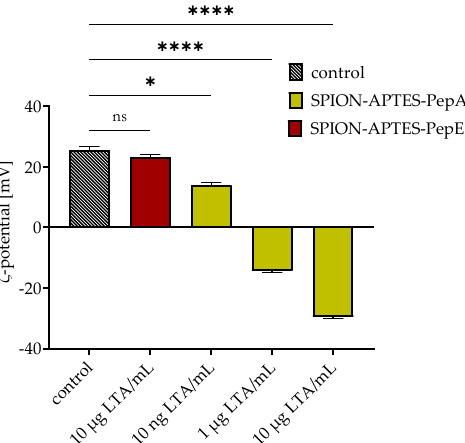
Figure 8. Changes in ζ -potential after separation of different amounts of LTA (10, 1000, and 10000 ng LTA/mL) using 300 µg Fe/mL of SPION-APTES-PepA and SPION-APTES-PepE. SPION-APTES- PepA without added LTA during separation served as control. The results shown represent the mean values with standard deviations of three independent experiments. Statistical testing was per- formed using a Kruskal – Wallis test with a post hoc Dunn’s test; * p ≤ 0.05; **** p < 0.0001. p values above 0.05 were considered non-significant (ns). 3.5. Removal and Enrichment of Separated Bacteria from Platelet Concentrate A potential application of the peptide-functionalized SPIONs is the separation of S. aureus from platelet concentrates. As mentioned before, bacterial contamination of these concentrates can cause serious infections with fatal outcomes [30]. As shown in Figure 9, SPION-APTES-PepA were able to remove 63% of the bacteria after one separation cycle. The amount of concentrated, particle-bound bacteria after the separation was increased by a factor of four compared with the untreated sample.